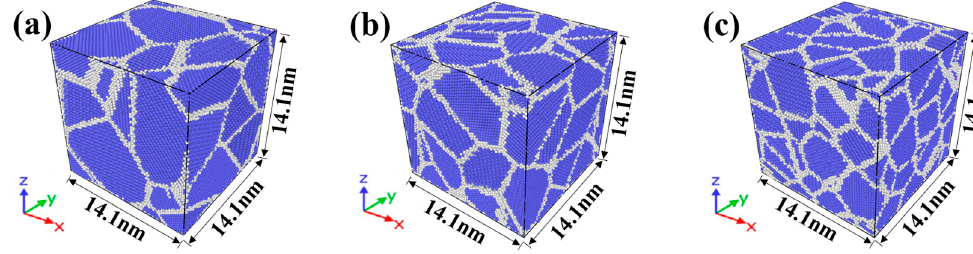
Figure 1. Nanocrystalline NiAl models with different grain sizes of ( a ) 6.5, ( b ) 4.5 and ( c ) 3.8 nm.